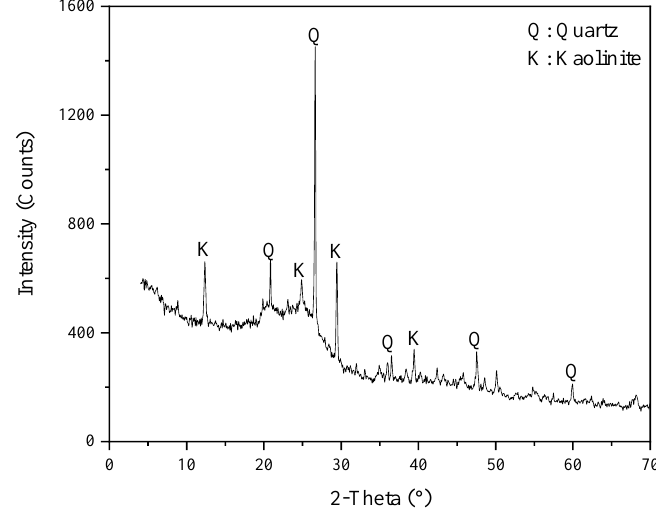
Figure 1. LRC sample of X-ray diffraction (XRD) analysis.